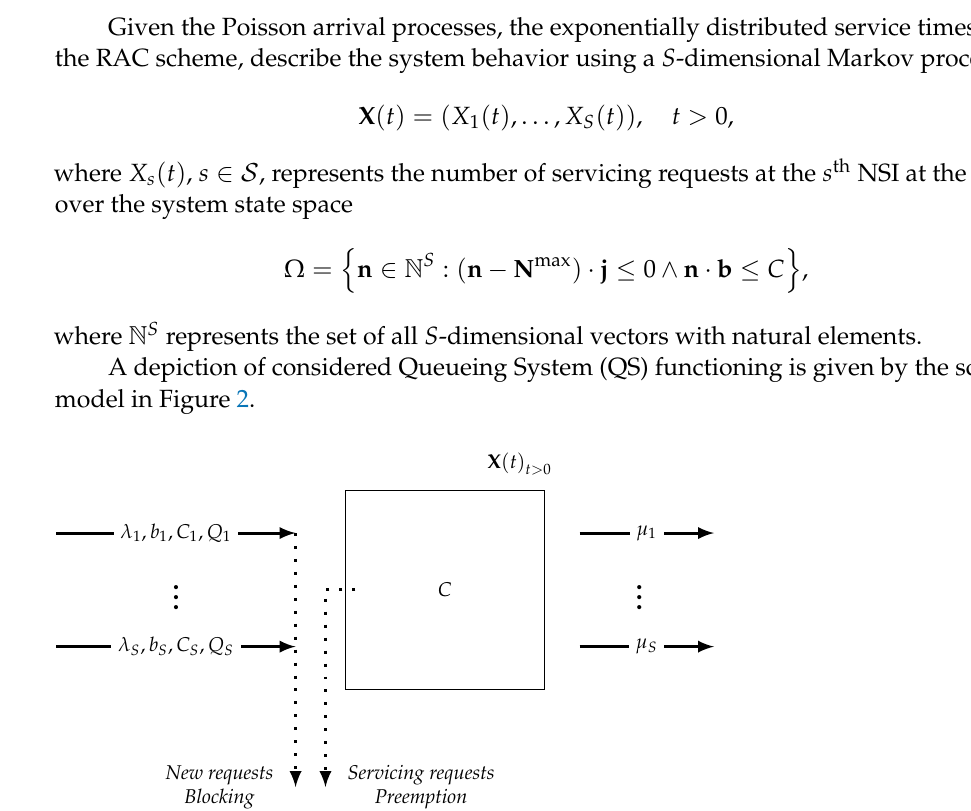
Figure 2. Scheme model of considered QS with S NSIs at the 5G